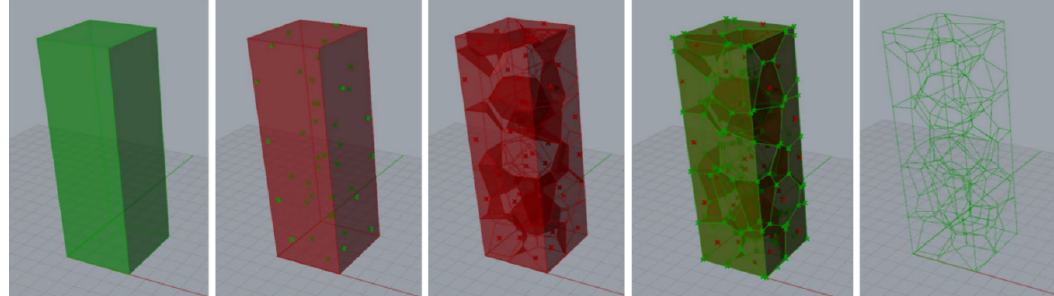
Figure 1. Process to achieve random structure in a space region by Voronoi tessellation [23].